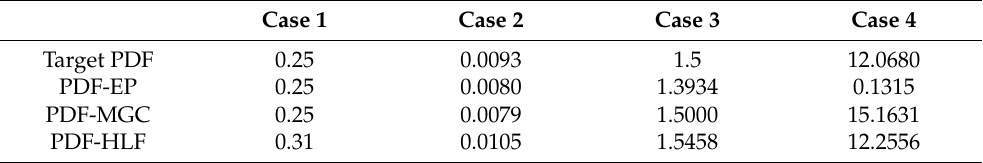
Table 2. Variances of the PDFs based on the three